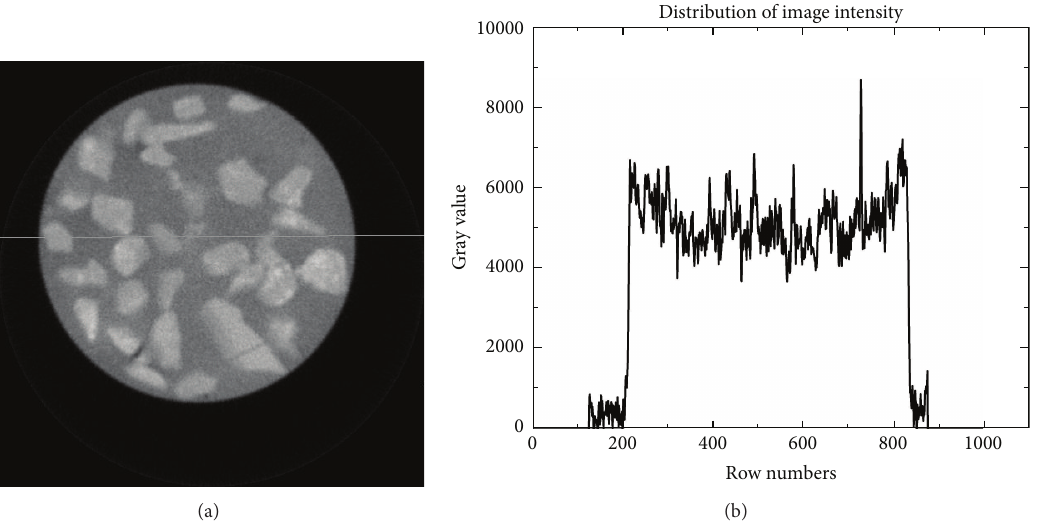
Figure 4: Beam-hardening artifacts. (a) Reconstructed CT image. (b) Distribution of image